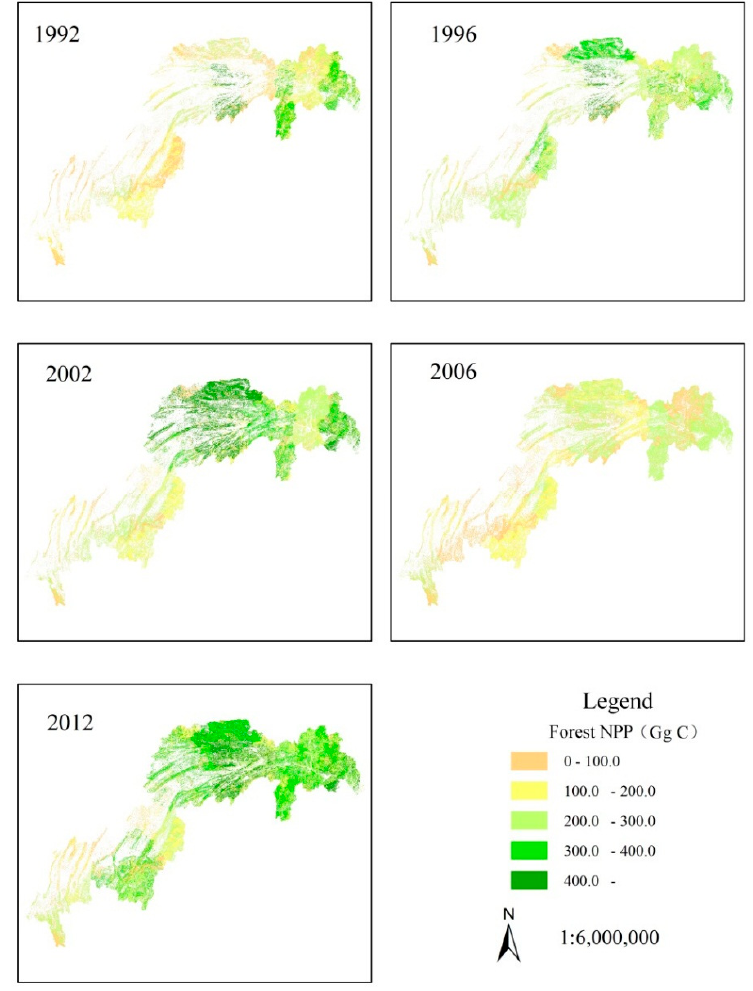
Figure 4. Spatial changes in forest NPP in the TGRA from 1992 to 2012.